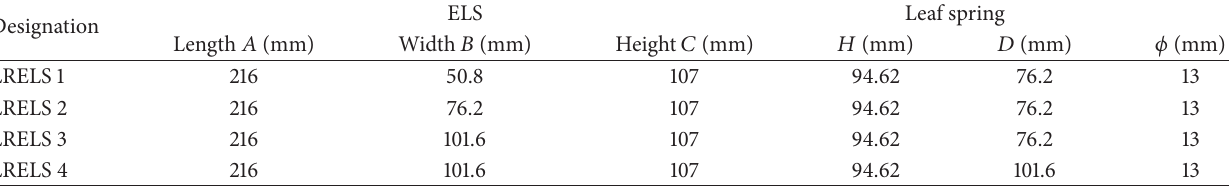
Table 1: Geometry of LRELS mounts considered in the